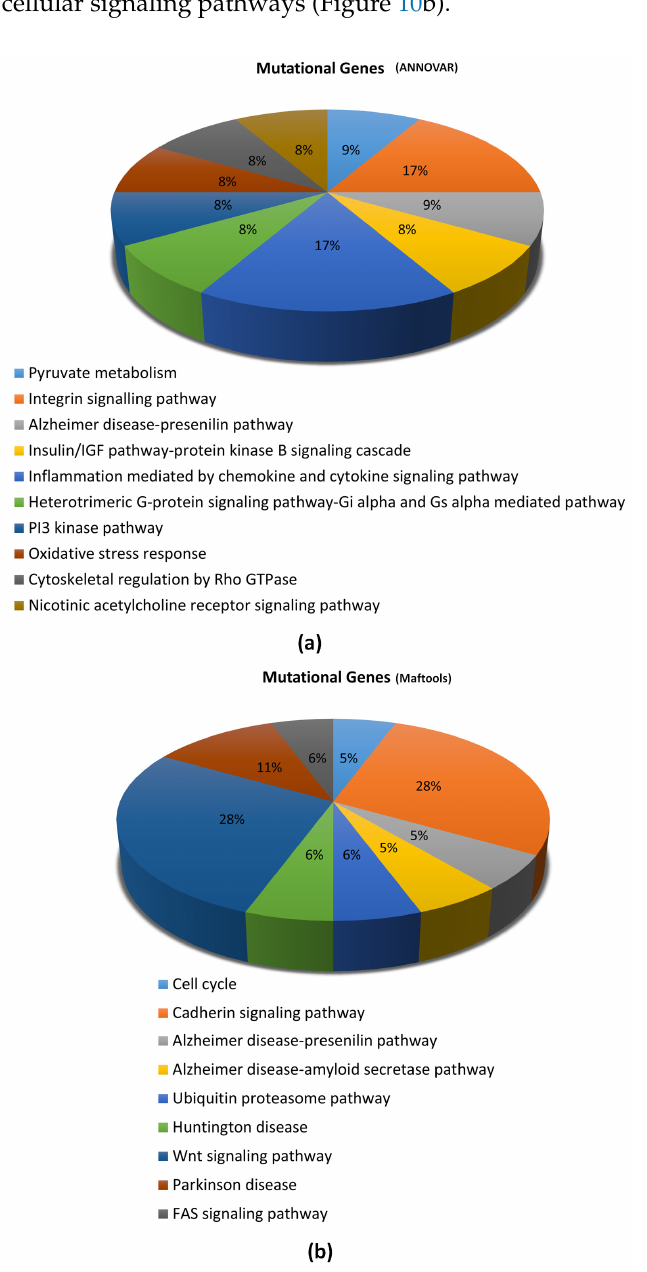
Figure 10. PANTHER analysis of signaling pathways associated with the top mutated genes identified using ( a ) ANNOVAR and ( b ) Maftools.